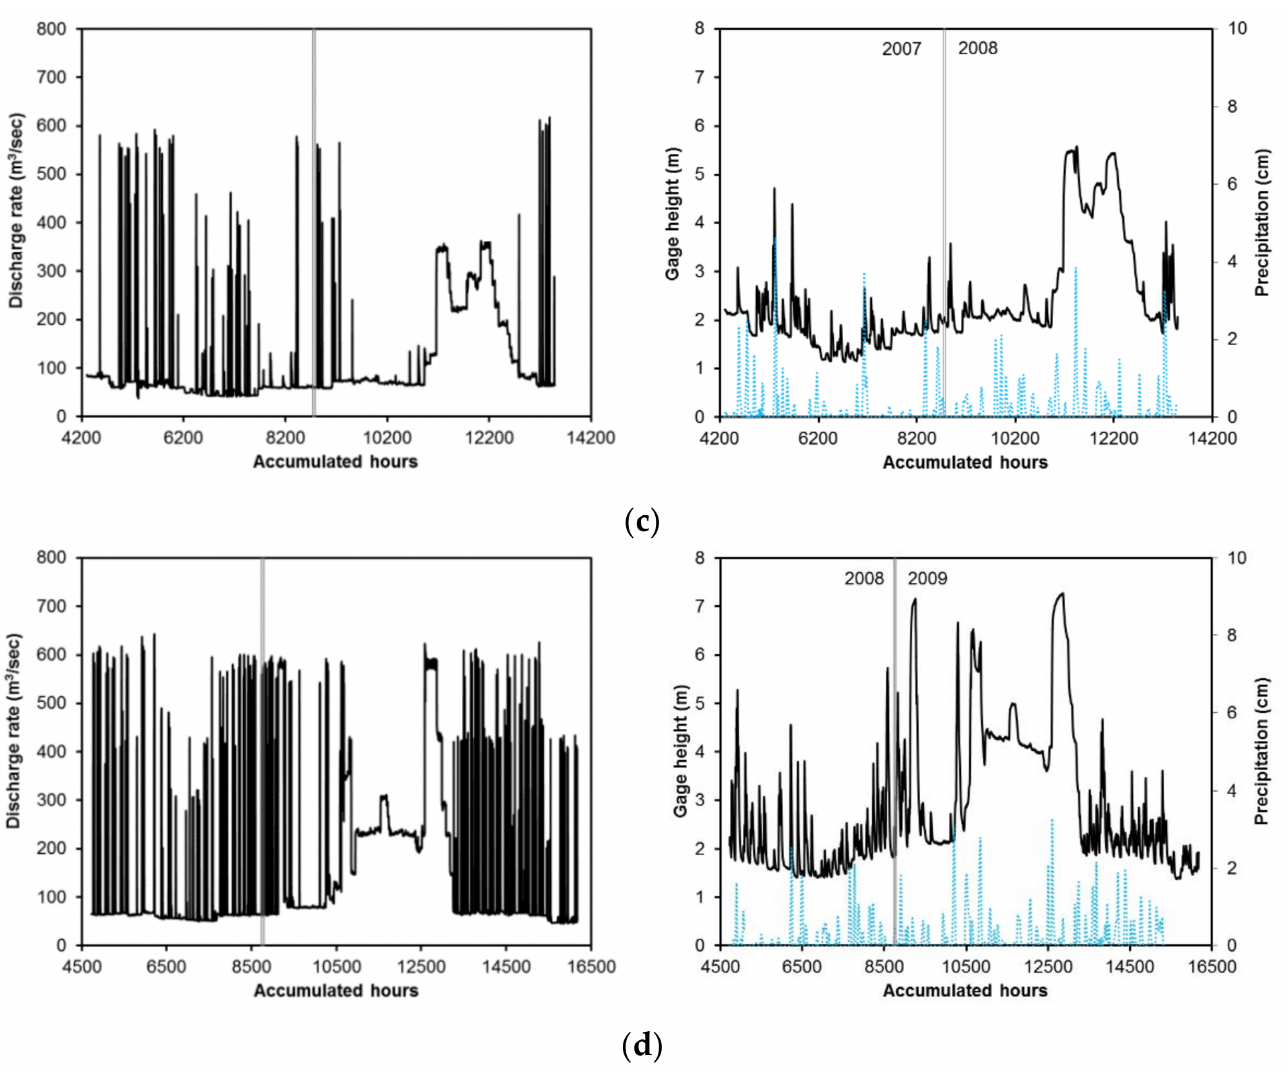
Figure 5. Roanoke Rapids hydropower dam discharge rates between 2005–2009: ( a ) October 2005–August 2006; ( b ) August 2006–June 2007; ( c ) July 2007–July 2008; ( d ) July 2008–November